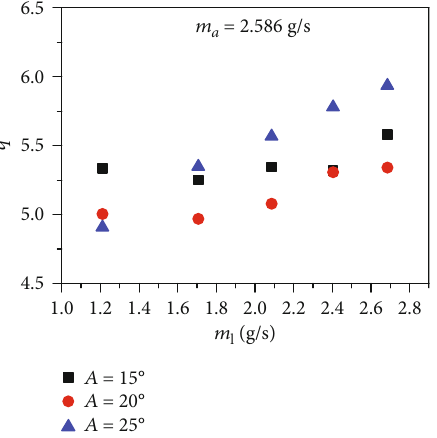
Figure 11: The drop size distribution parameter q of A series nozzle with various mass fl ow rates of fuel at air mass fl ow rate of ma = 2 : 586